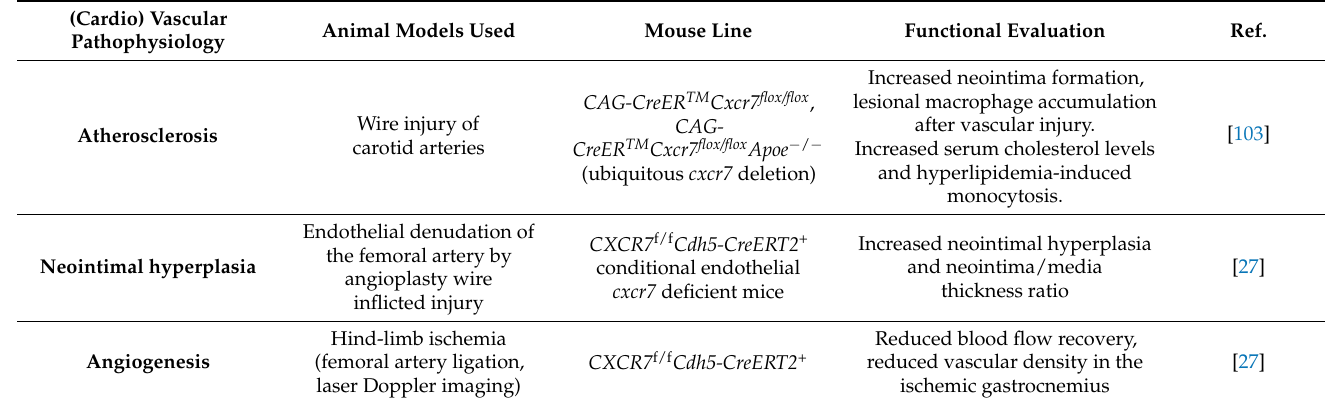
Figure 4. Therapeutic implementation of ACKR3/CXCR7 in platelet-associated pathologies. Thera- peutic potential of ACKR3/CXCR7 has been demonstrated using pharmacological agonists in disease models of atheroprogression, arterial thrombosis, myocardial infarction, cerebral stroke, in impeding pulmonary fibrosis and in promoting hepatic regeneration. Table 1. Relevance of ACKR3/CXCR7 in vascular